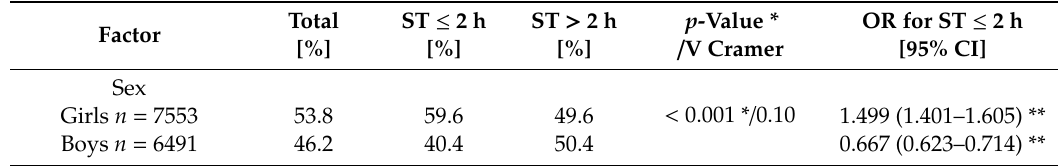
Figure 1. The results of the analysis of correspondence of nutritional behaviors and screen time duration in the total study group ( n = 14,044). Beneficial behaviors are marked in green; unfavorable behaviors are marked in red. Table 2. Characteristics of the study group ( n = 14,044), depending on the screen time (ST) duration and the odds ratio (OR; CI, confidence interval) for screen time duration within the recommendations ( ≤ 2 h) depending of analyzed